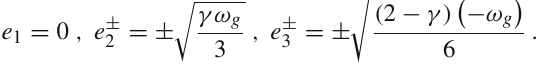
Fig. 5 Phase-space diagram for the dynamical system (31)–(35) on the β − ε surface , for γ = 4 different values of h around the h ( P 1 ) = 0